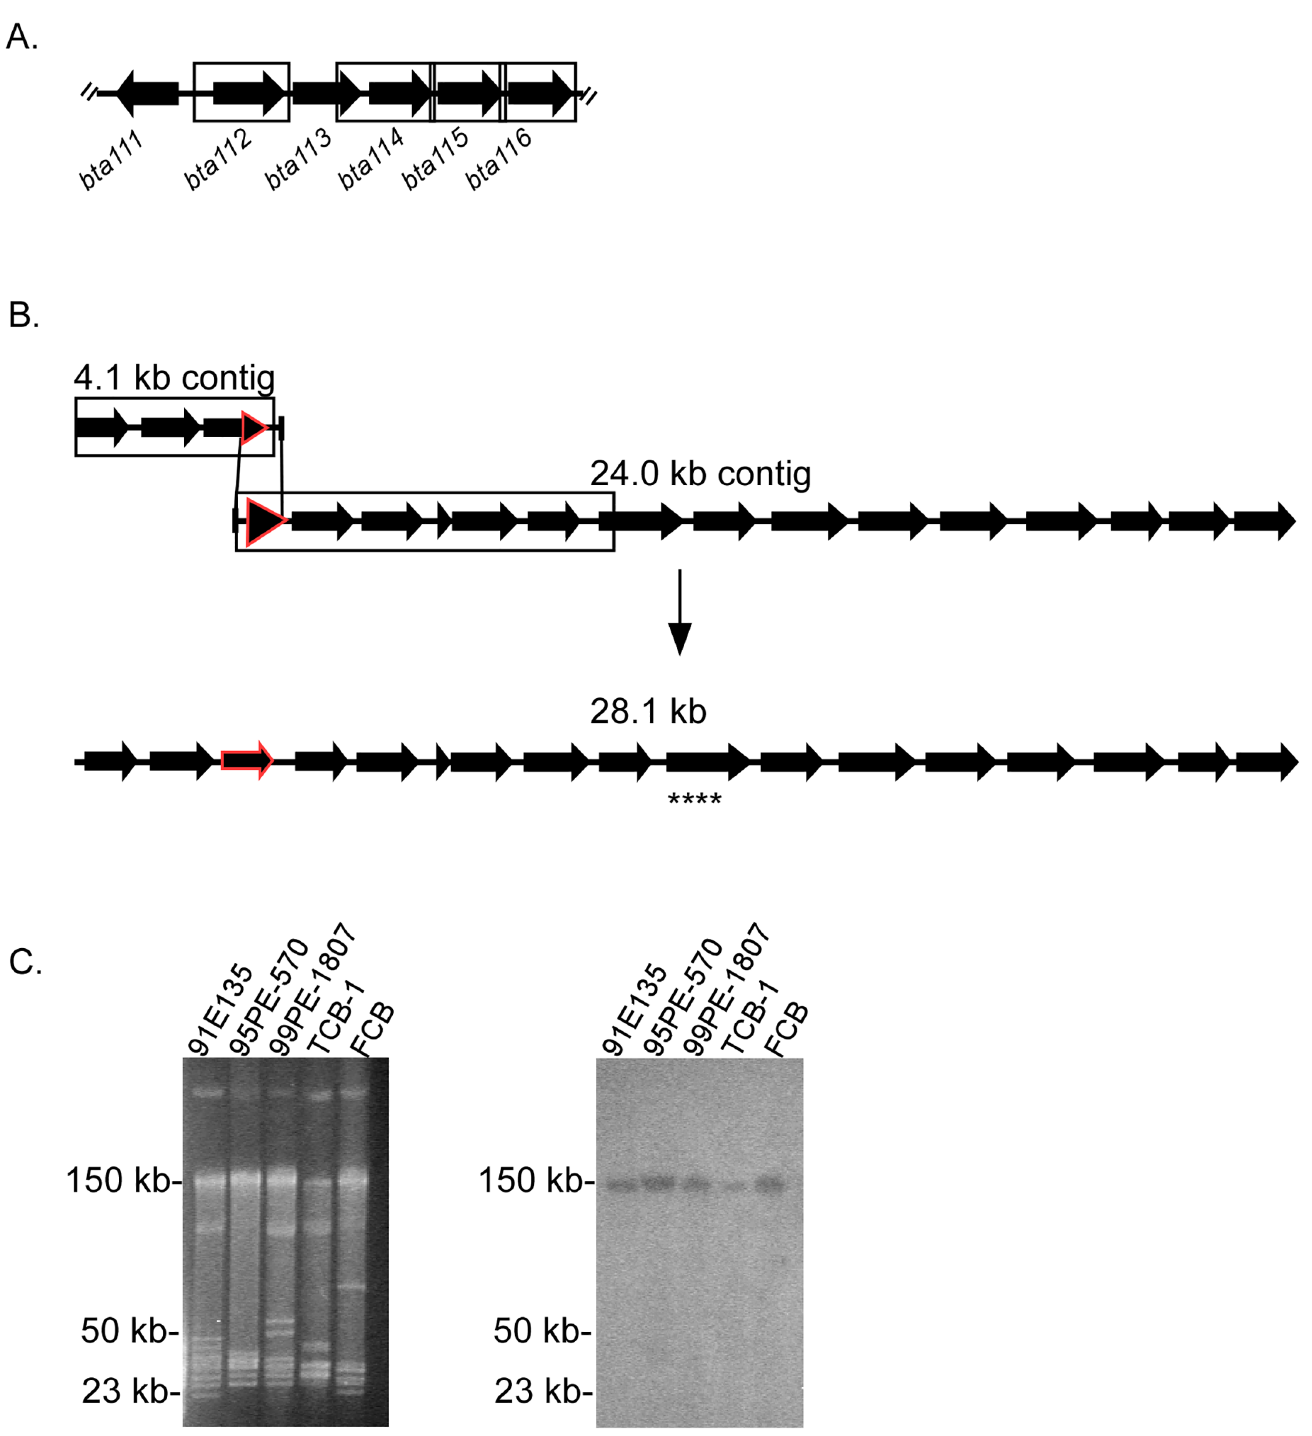
Fig 1. Identification and assembly of two contigs that comprise the 3 ’ end of lp150. Six genes at the right end of the partially assembled lp150 ( bta111 to bta116 ) are shown as arrows, while boxes represent regions of direct and inverted repeats that share similarity between a 4.1 and 24.0 kb contig (A and B). The red highlighted arrows on the 4.1 and 24.0 kb contigs represent nucleotide identity that led to the assembly of a 28.1 kb contig (B). The location of a southern blot probe designed for the 28.1 kb contig is represented by four asterisks (B). A pulse-field agarose gel (C, left) and southern blot (C, right) display the genetic profile and localization of the 28.1 kb contig to lp150, respectively. B . turicatae isolates are shown on the top (C), and molecular size standards are on the left of each